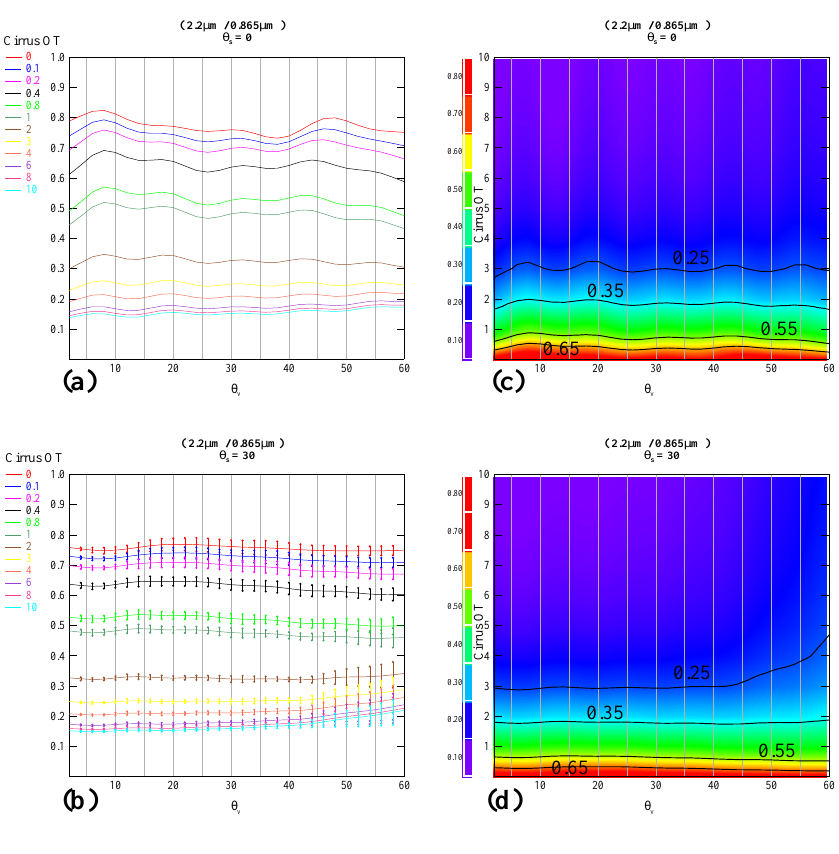
Fig. 7. Simulation for different geometries of the 2.1µm to 865 nm reflectance ratio for an ice cloud of varying optical thickness overlaying a lower liquid water cloud of optical thickness 10. Panels (a) and (b) present the simulated ratio for different cirrus optical thickness as a function of viewing angle. Results are averaged over relative azimuth and standard deviations are indicated using error bars. Panels (c) and (d) present the same results as a surface contour of simulated ratio, function of viewing angle and cirrus optical thickness. The latter representation is used to better illustrate the different regions defined by the SWIR vs. VIS/NIR reflectance thresholds used in our